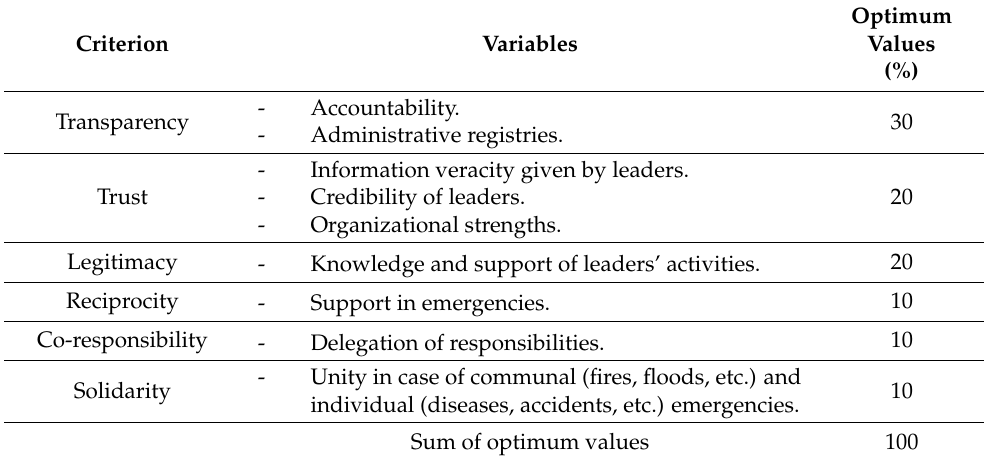
Table 3. Specific indicators and variables of social capital.